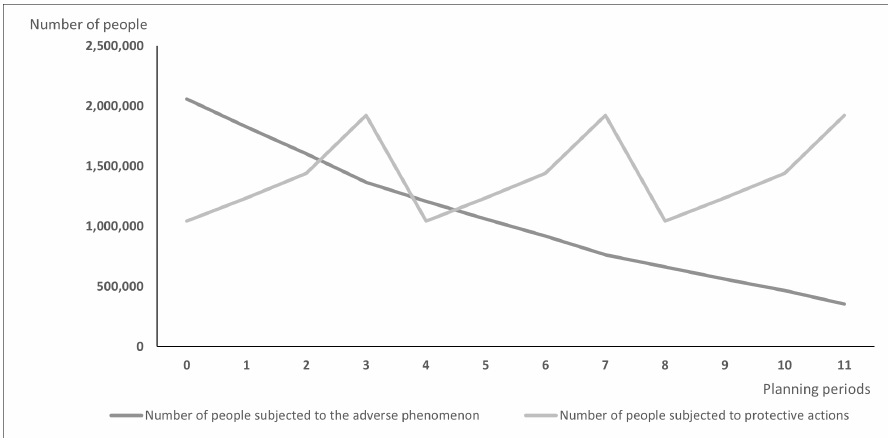
Figure 1. The results obtained using the PDPA model for the entire population.